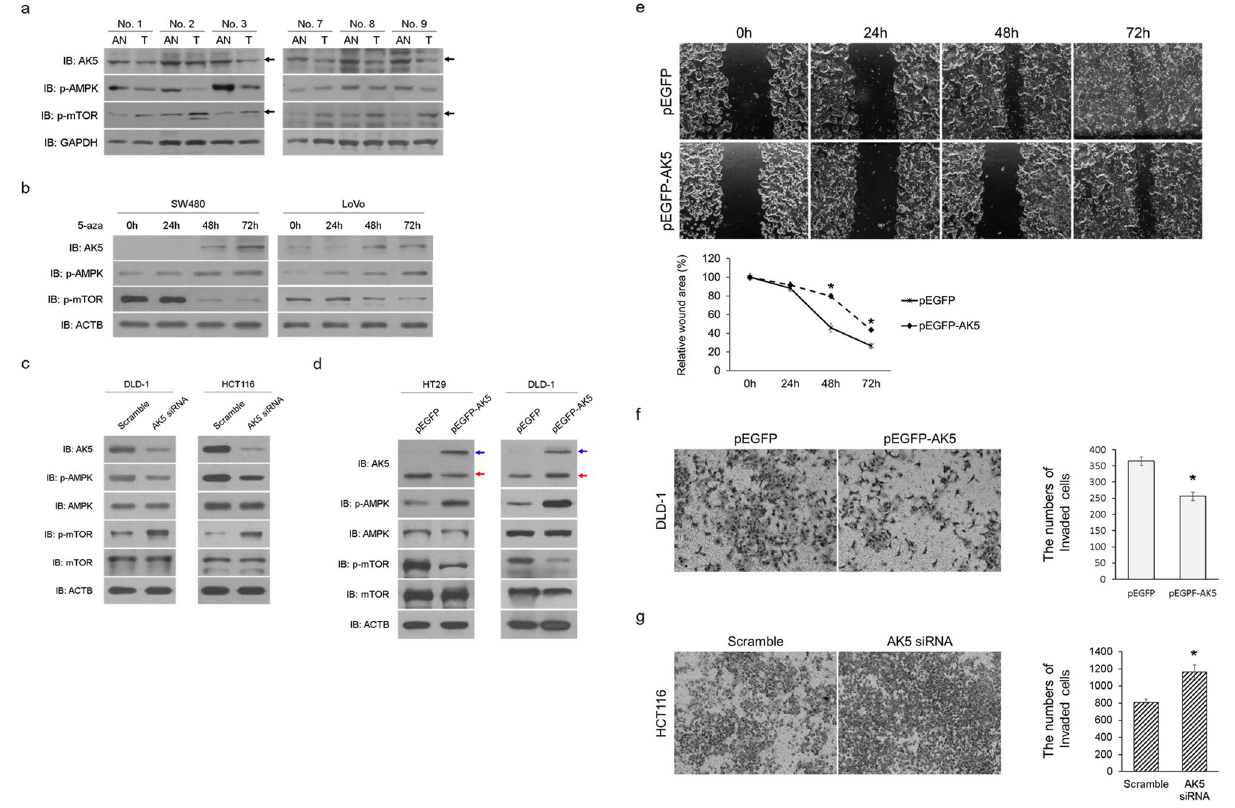
Figure 4. The role of AK5 in the AMPK/mTOR signal pathway in CRC cells. AK5 protein expression, phosphorylated AMPK, and mTOR phosphorylation levels were investigated using immunoblot analysis in three paired CRC tissues and adjacent normal tissues. ( a ) AK5 and AMPK phosphorylation decreased in CRC tissues compared to adjacent normal tissues. However, phosphorylated mTOR increased in CRC. AK5 protein expression, phosphorylated AMPK, and mTOR phosphorylation were investigated using immunoblot analysis in CRC cell lines after treatment with 5-aza for 1–3 days. ( b ) 5-aza increased AK5 expression in a time- dependent manner in SW480 and LoVo cells. AMPK phosphorylation increased for 2 days before decreasing 3 days after 5-aza treatment. Phosphorylated mTOR was decreased by 5-aza in both CRC cells. ( c ) AMPK phosphorylation decreased and mTOR phosphorylation increased when AK5 expression was inhibited by AK5 siRNA transfection into DLD-1 and HCT116 cells for 2 days. ( d ) AK5 overexpression induced AMPK phosphorylation and decreased phosphorylated mTOR in HT-29 and DLD-1 cell lines after transfection with the overexpression vector for 2 days. The blue arrow shows AK5-GFP, and the red arrow shows only AK5. ( e ) The migration of HT-29 cells was significantly reduced after 48 h in AK5 overexpression cells transfected with pEGFP-AK5 compared to pEGFP transfected cells. ( f ) The invasion of DLD-1 cells was significantly reduced after 24 h in AK5 overexpressing cells transfected with pEGFP-AK5 compared to pEGFP transfected cells. ( g ) The invasion of HCT116 cells was significantly increased after 24 h in AK5 knockdown cells transfected with AK5 siRNA compared to scramble siRNA transfected cells. Full-length bolts images or original gel images of AK5 protein expression are presented in Figure S5a, S5c, S5d, S5e and S5f. Original magnification: × 200. GAPDH or ACTB was used as loading controls. IB immunoblot, AN adjacent normal, T colorectal cancer, 5-aza 5-aza-2 ′ -deoxycytidine. *P-values of < 0.05 were considered statistically